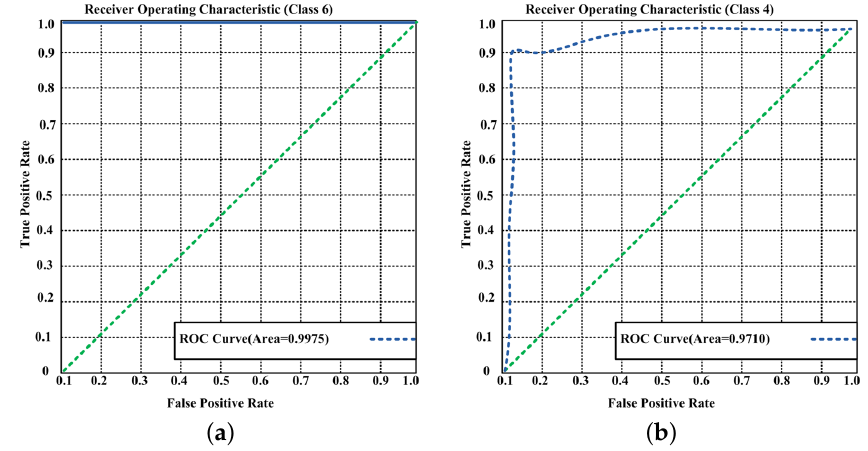
Figure 8. ROC curve for ( a ) Class 6 and ( b ) Class 4.